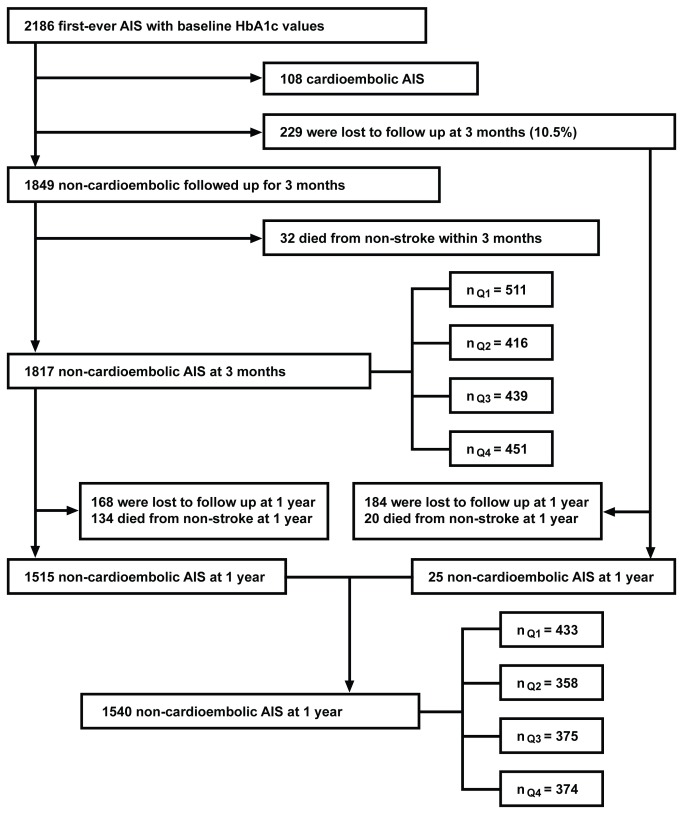
Flow chart of patient selection.AIS indicates acute ischemic stroke; Q1, HbA1c level of <5.5%; Q2, HbA1c level of 5.5 to <6.1%; Q3, HbA1c level of 6.1 to <7.2%; Q4, HbA1c level of ≥7.2%.